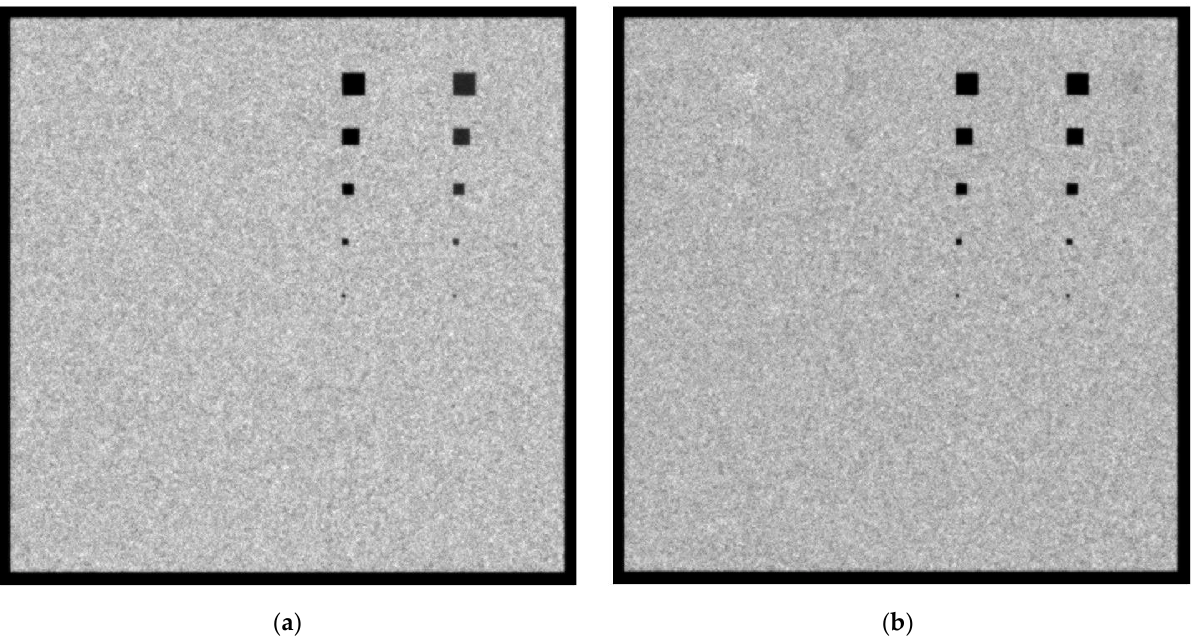
Figure 6. A 4.2 cm phantom image for Mo/Mo 3 mGy and 32 kVp spectrum with ( a ) 0.1 cm lesion thickness and ( b ) 0.5 cm lesion thickness.